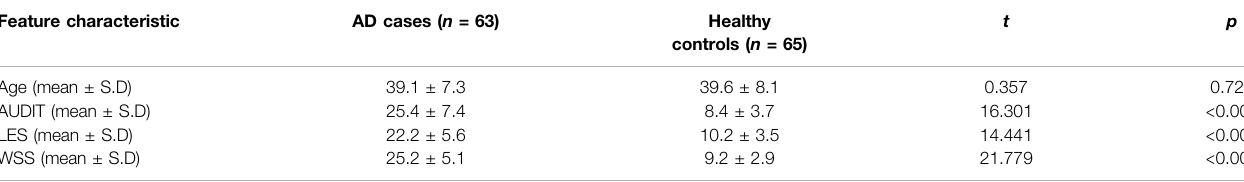
TABLE 1 | Basic characteristic of the study population.